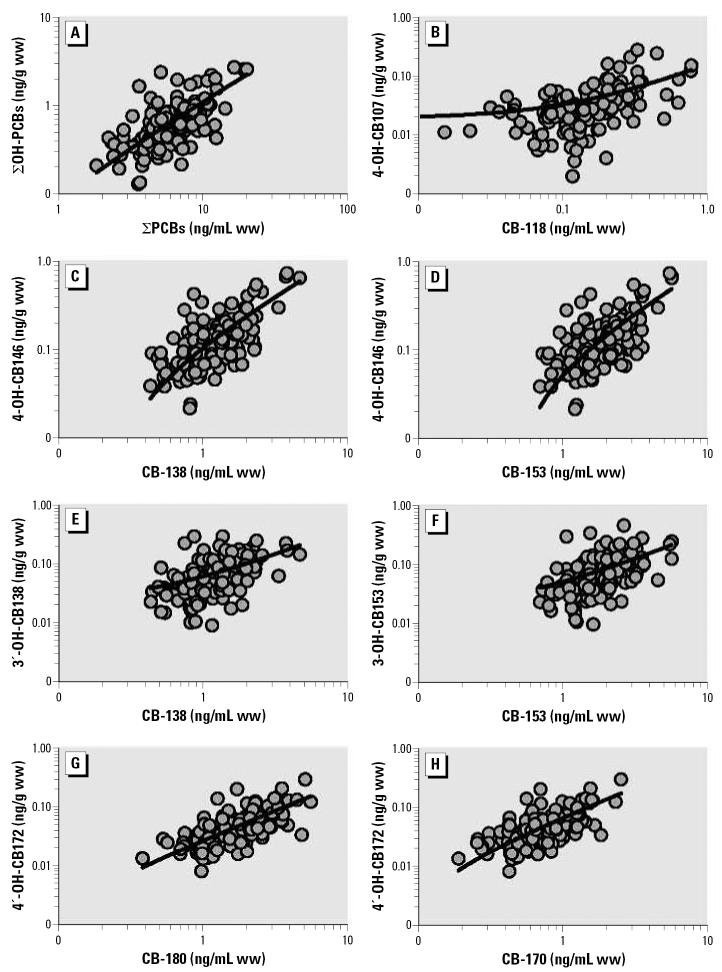
Best fitting linear regressions indicating statistical relationships between ∑PCBs and ∑OH-PCBs (A; R2 = 0.47) and between specific PCB precursors and OH-PCB metabolites in maternal sera from Slovakia: (B) CB-118 and 4-OH-CB107 (R2 = 0.24); (C) CB-138 and 4-OH-CB146 (R2 = 0.53); (D) CB-153 and 4-OH-CB146 (R2 = 0.52); (E) CB-138 and 3′ -OH-CB138 (R2 = 0.22); (F) CB-153 and 3-OH-CB153 (R2 = 0.22); (G) CB-180 and 4′ -OH-CB172 (R2 = 0.39); and (H) CB-170 and 4′ -OH-CB172 (R2 = 0.43).